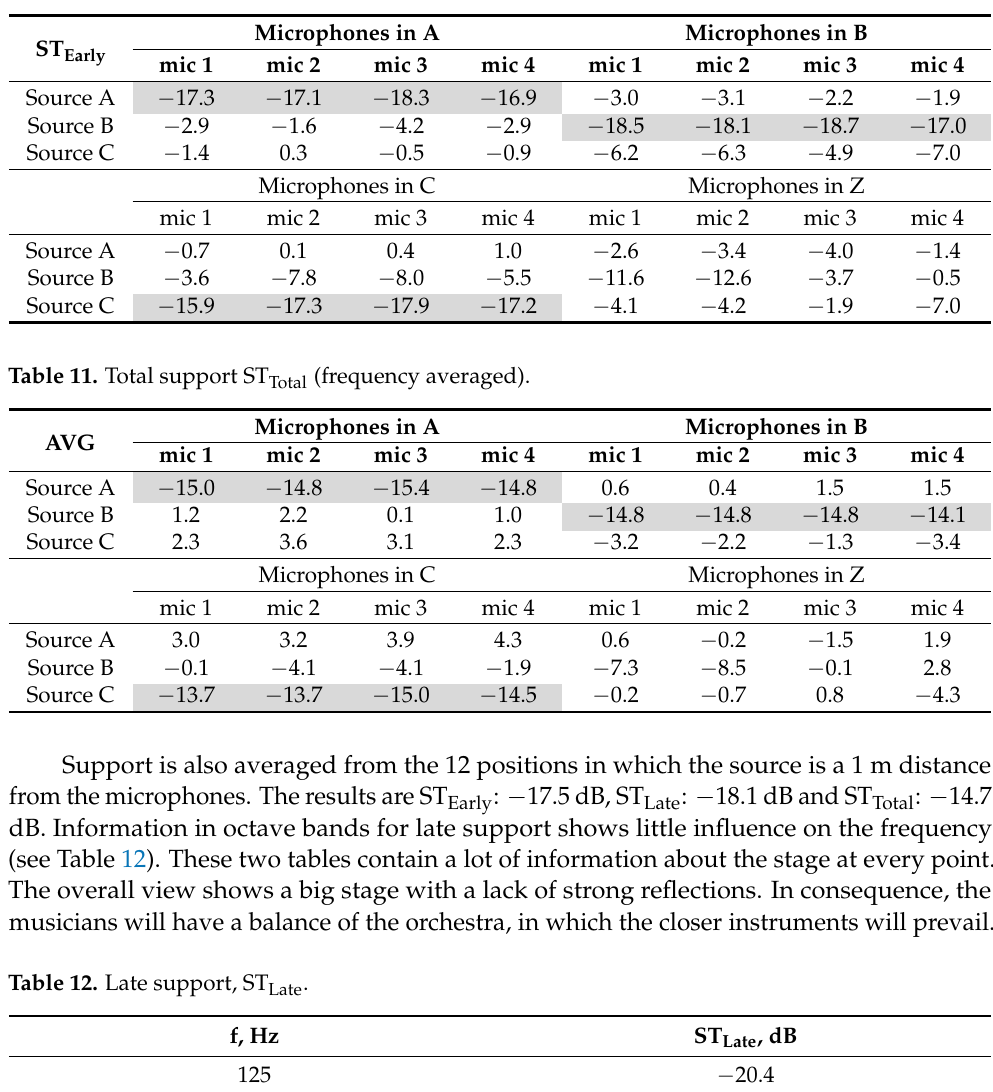
Table 10. Early support ST Early (250–2000 Hz frequency averaged).